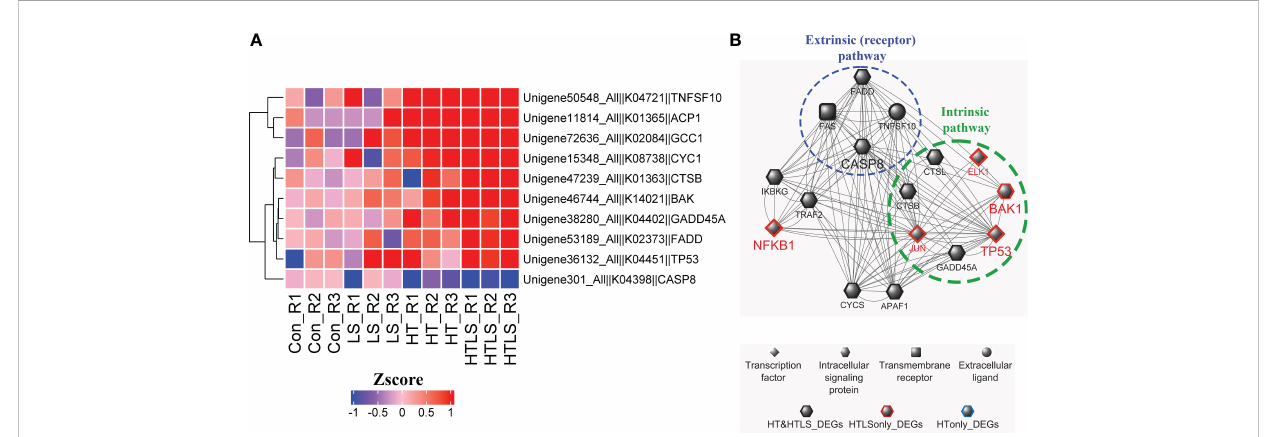
FIGURE 6 Differential expression of components involved in apoptosis pathways in HT and HTLS treatments. The heatmap in (A) provides the expression patterns of DEGs mapped to the KEGG apoptosis map. (B) Reconstructed based on STRING human PPI database, a protein-protein interaction network of the DEGs involved in apoptosis is illustrated. Components involved in the extrinsic (receptor-mediated) and intrinsic (caspase- independent) pathways of apoptosis were also